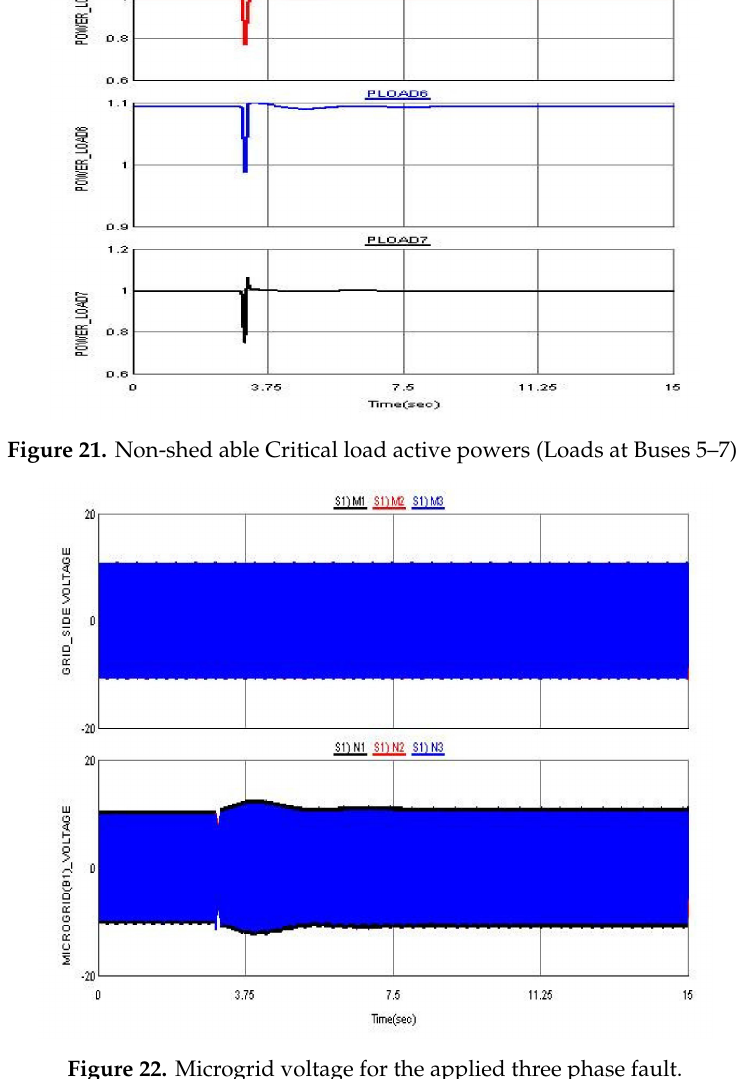
Figure 22. Microgrid voltage for the applied three phase